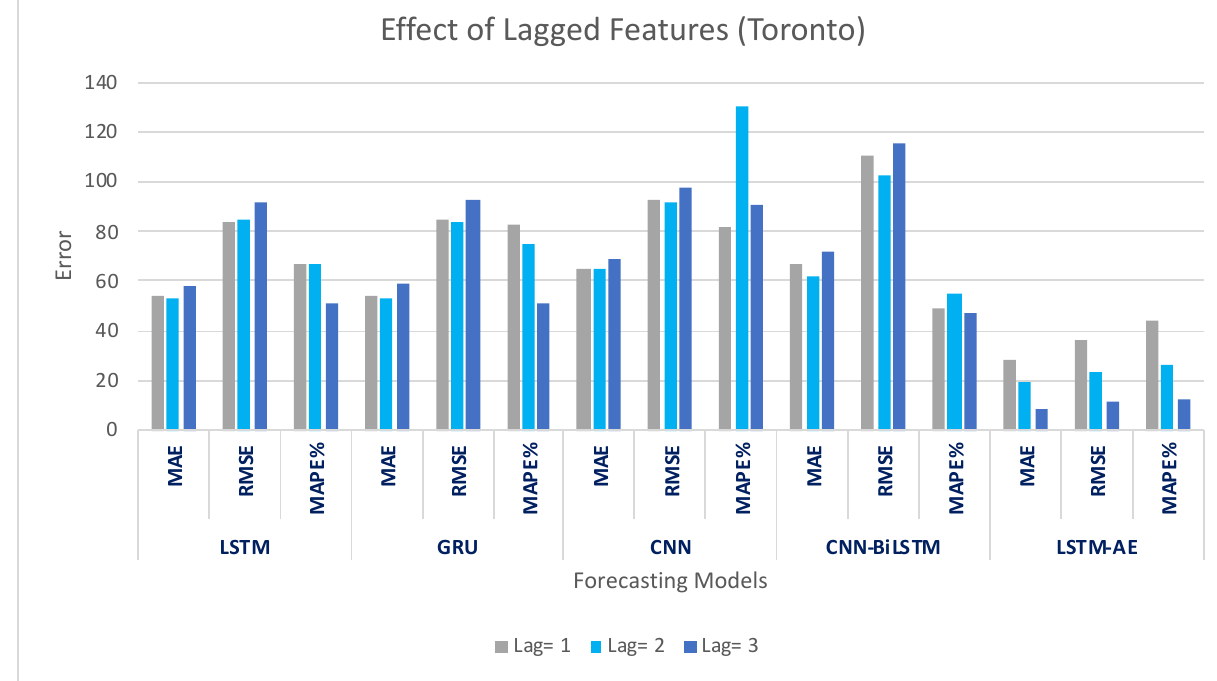
Figure 22. The effect of the lagged features on Toronto dataset.